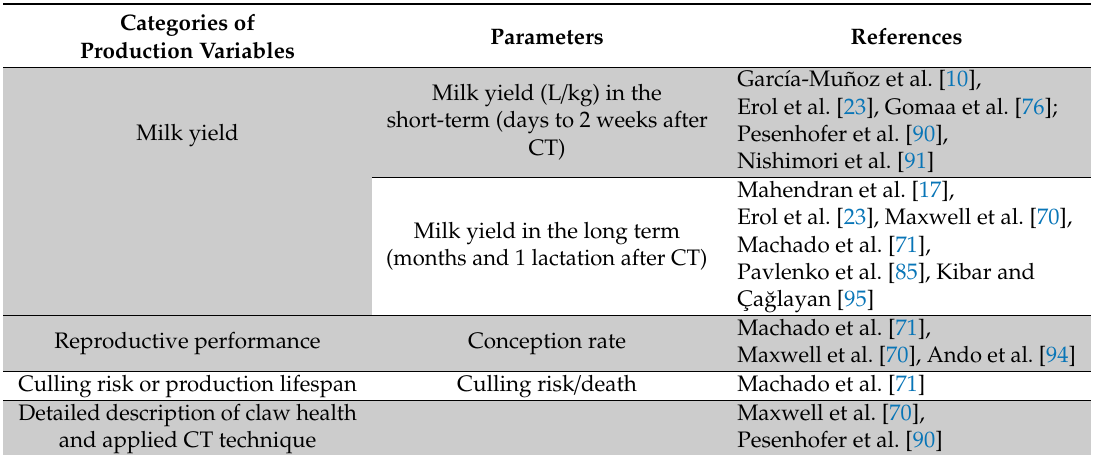
Table 3. Reviewed studies reporting associations between claw trimming and production variables in dairy cows and specific studies with detailed description of claw health and applied CT